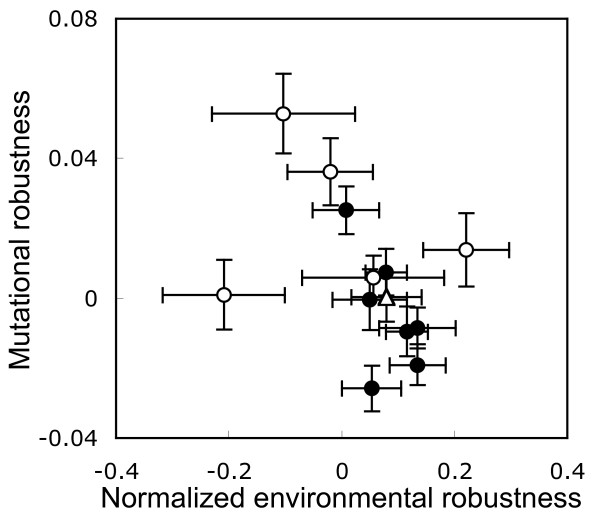
Relationship between environmental and mutational robustness. Because different environmental stresses had different mean effects on growth rate we normalized the effect of each stress to have a mean of zero. Therefore values on this axis above zero do not indicate that the effect of stress was positive. Average of median values plotted. Error bars indicate standard errors. Reference strain, hollow triangle; random disruption strains, solid circles; targeted hub disruption strains, hollow circles.